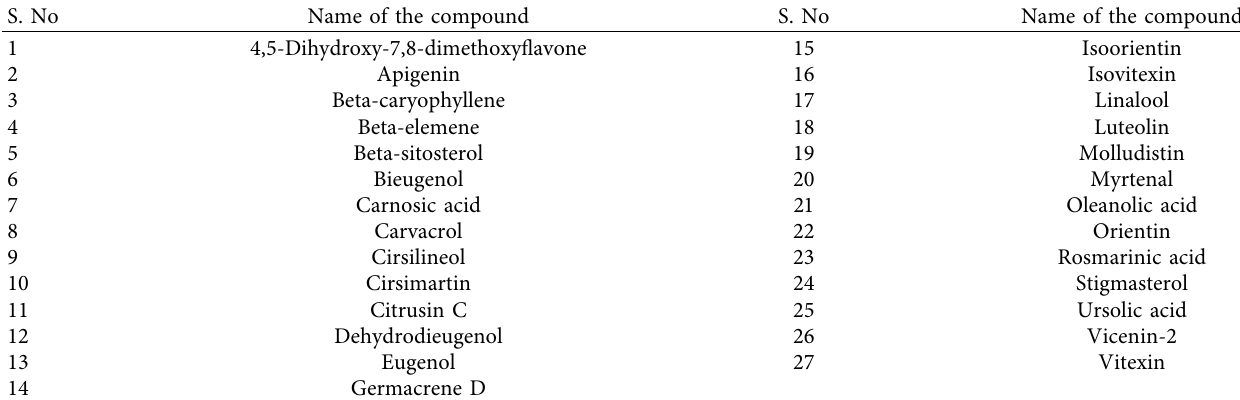
Table 1: The identified phytochemical compounds in the